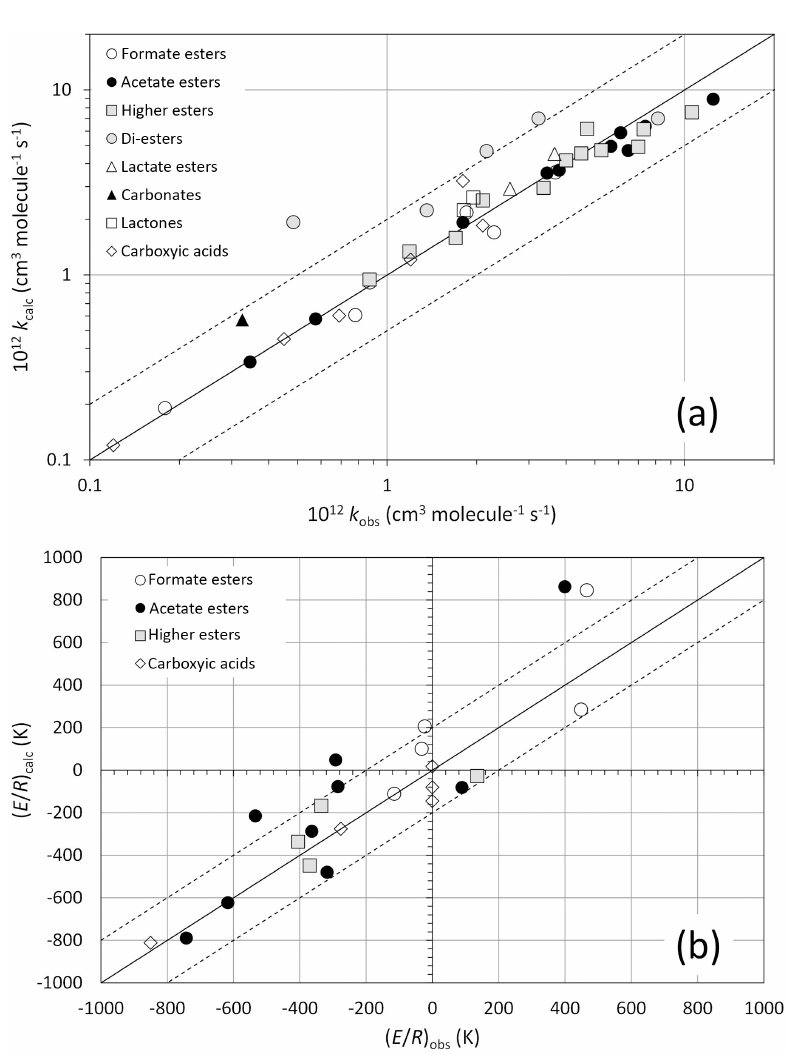
Figure 4. (a) A log–log correlation of k calc and k obs at 298K for saturated esters and carboxylic acids. The broken lines show the factor of 2 range (see Table S1 for identities of outliers). (b) A correlation of the temperature coefficients (E/R) calc and (E/R) obs for the same compound classes. The broken lines show the ± 200K